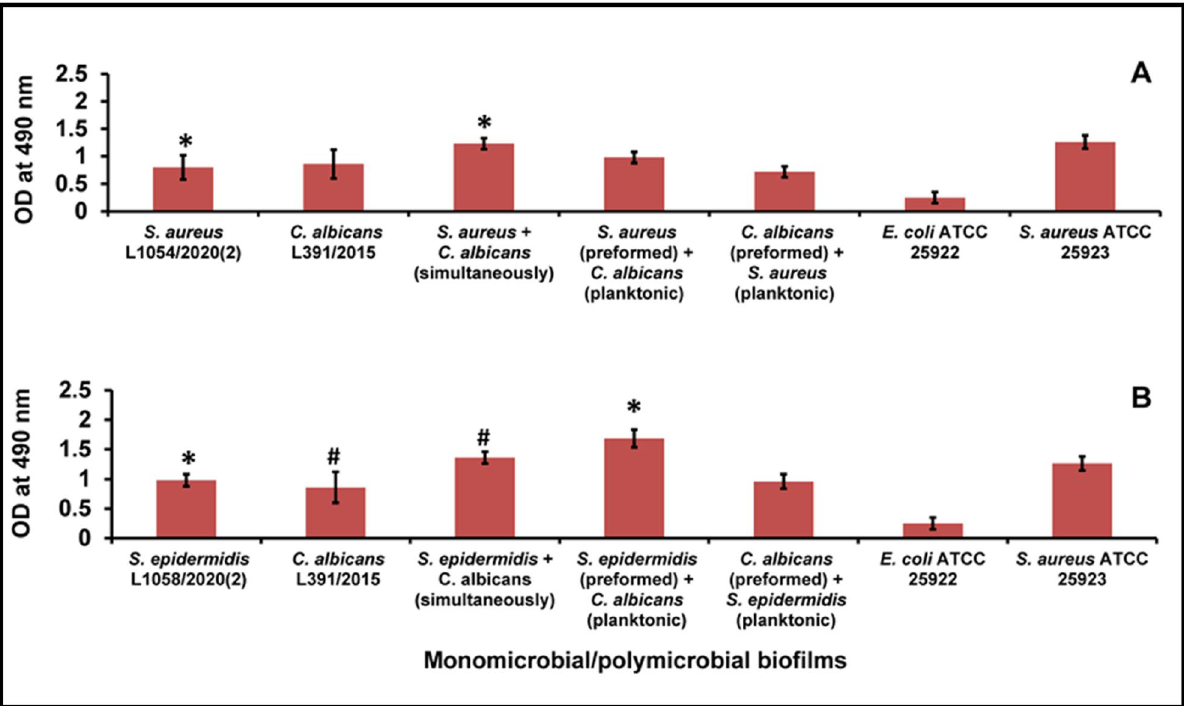
Figure 1. Quantification of polymicrobial biofilm formation in S. aureus ( A ) and S. epidermidis ( B ) with C. albicans by the XTT method after 48 h of biofilm formation compared to the monomicrobial biofilms of S. aureus , S. epidermidis and C. albicans . Similar superscripts * and # indicate significant increase (p value < 0.05) in polymicrobial biofilm compared to the respective monomicrobial biofilm at 48 h. Unpaired t test was used for the calculation of p value. S. aureus ATCC 25923 was used as a positive control and E. coli ATCC 25922 was used as a negative control. Experiments were performed in triplicates. Values represent XTT absorbance at 495 nm expressed as average ± standard